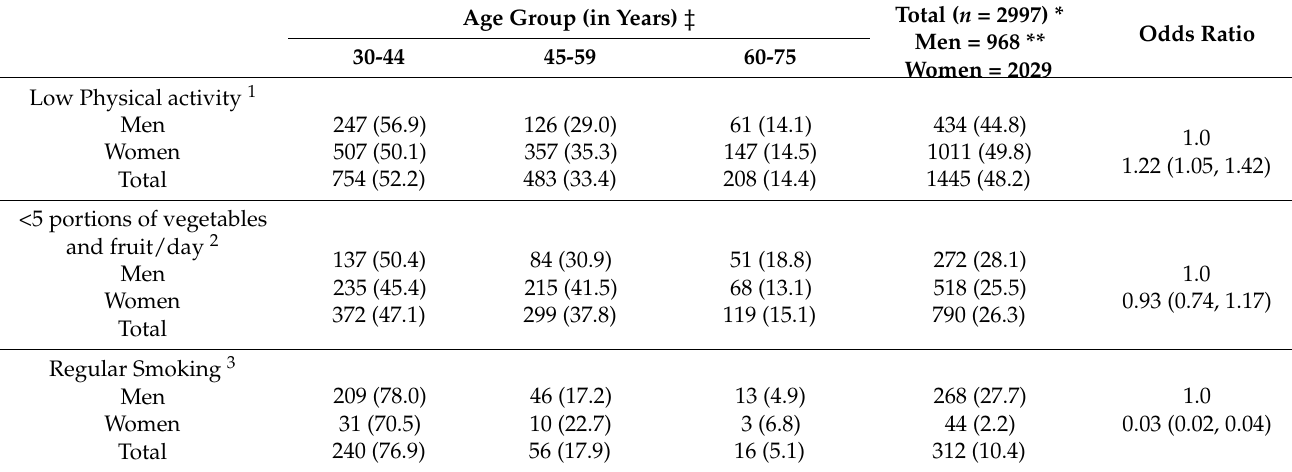
* Column percentage; ‡ Row percentage; ** Men were 1.49 (1.28, 1.74) times more likely to have an unhealthy lifestyle. 1 Low physical activity: <1200 METs min/week ( p = 0.04). 2 <5 portions equal to <400 gms ( p > 0.05); 3 p =